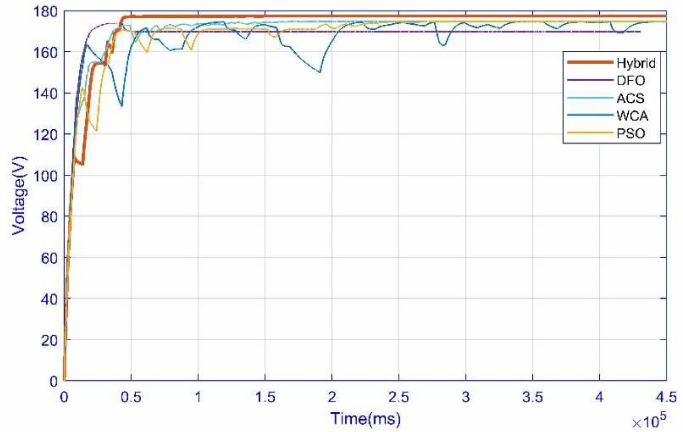
Figure 14. Case 3: Voltage comparison of hybrid with other